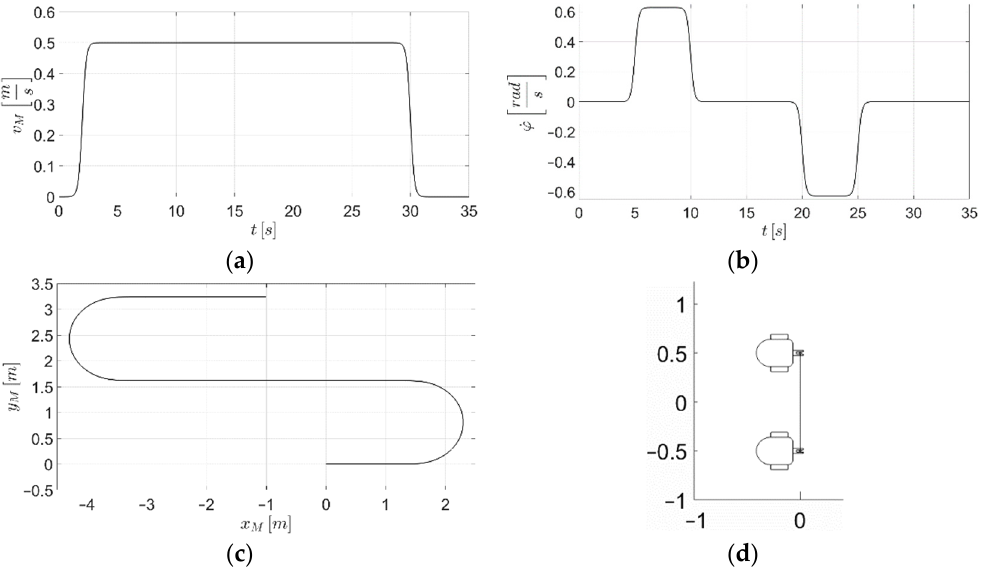
Figure 4. ( a ) Velocity profile of the M point, ( b ) angular velocity of the transported beam, ( c ) the generated path of the M point motion, and ( d ) the initial setting of the robots and the beam in the emulator.